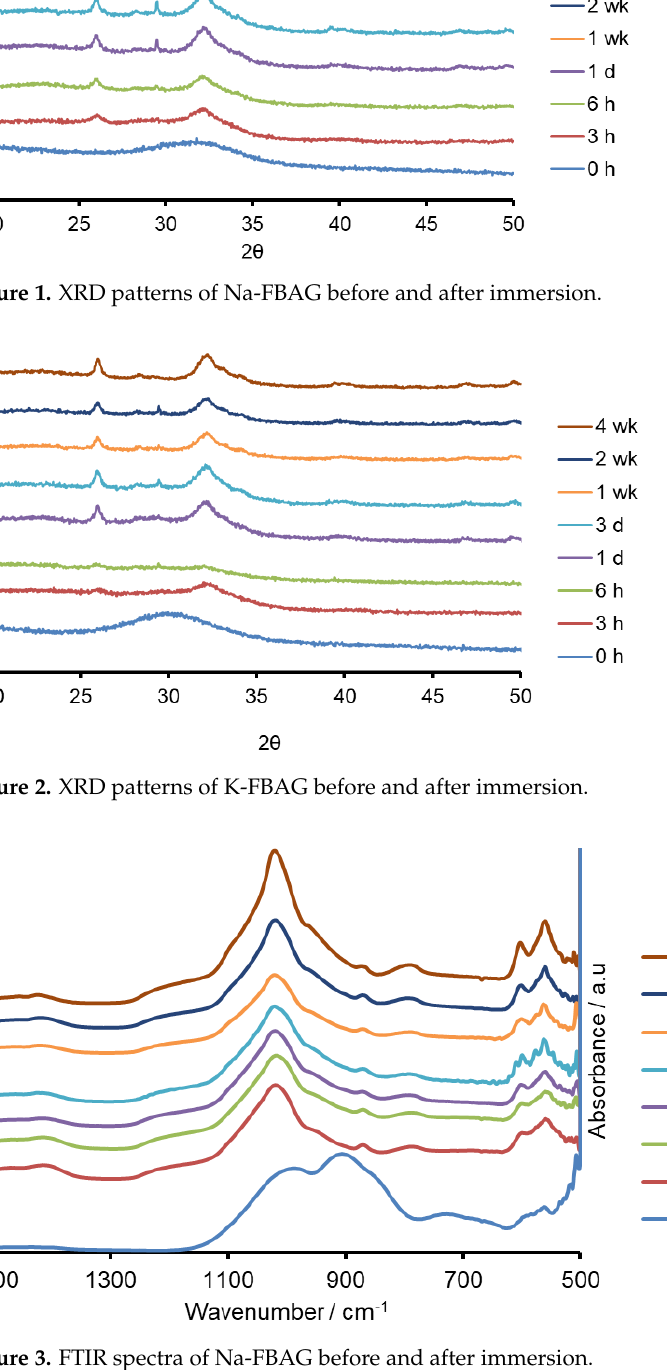
Figure 4. FTIR spectra of K-FBAG before and after immersion. Figure 5. DSC traces of Na-FBAG (  ) and K-FBAG (  ).